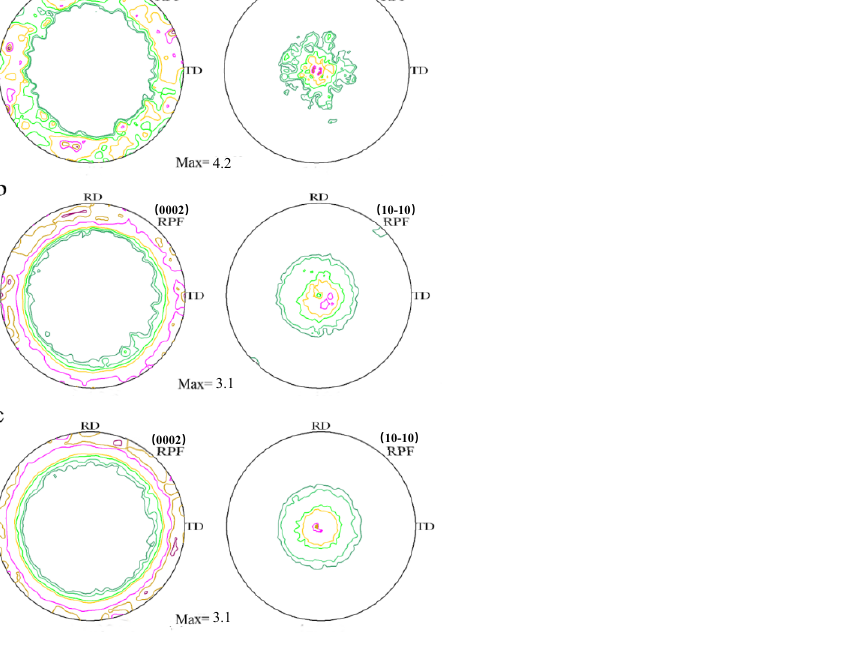
Figure 7. Pole figure of as-extruded Mg–Al alloys measured by X-ray diffraction: ( a ) Mg, ( b ) Mg–2Al, ( c ) Mg–4Al.